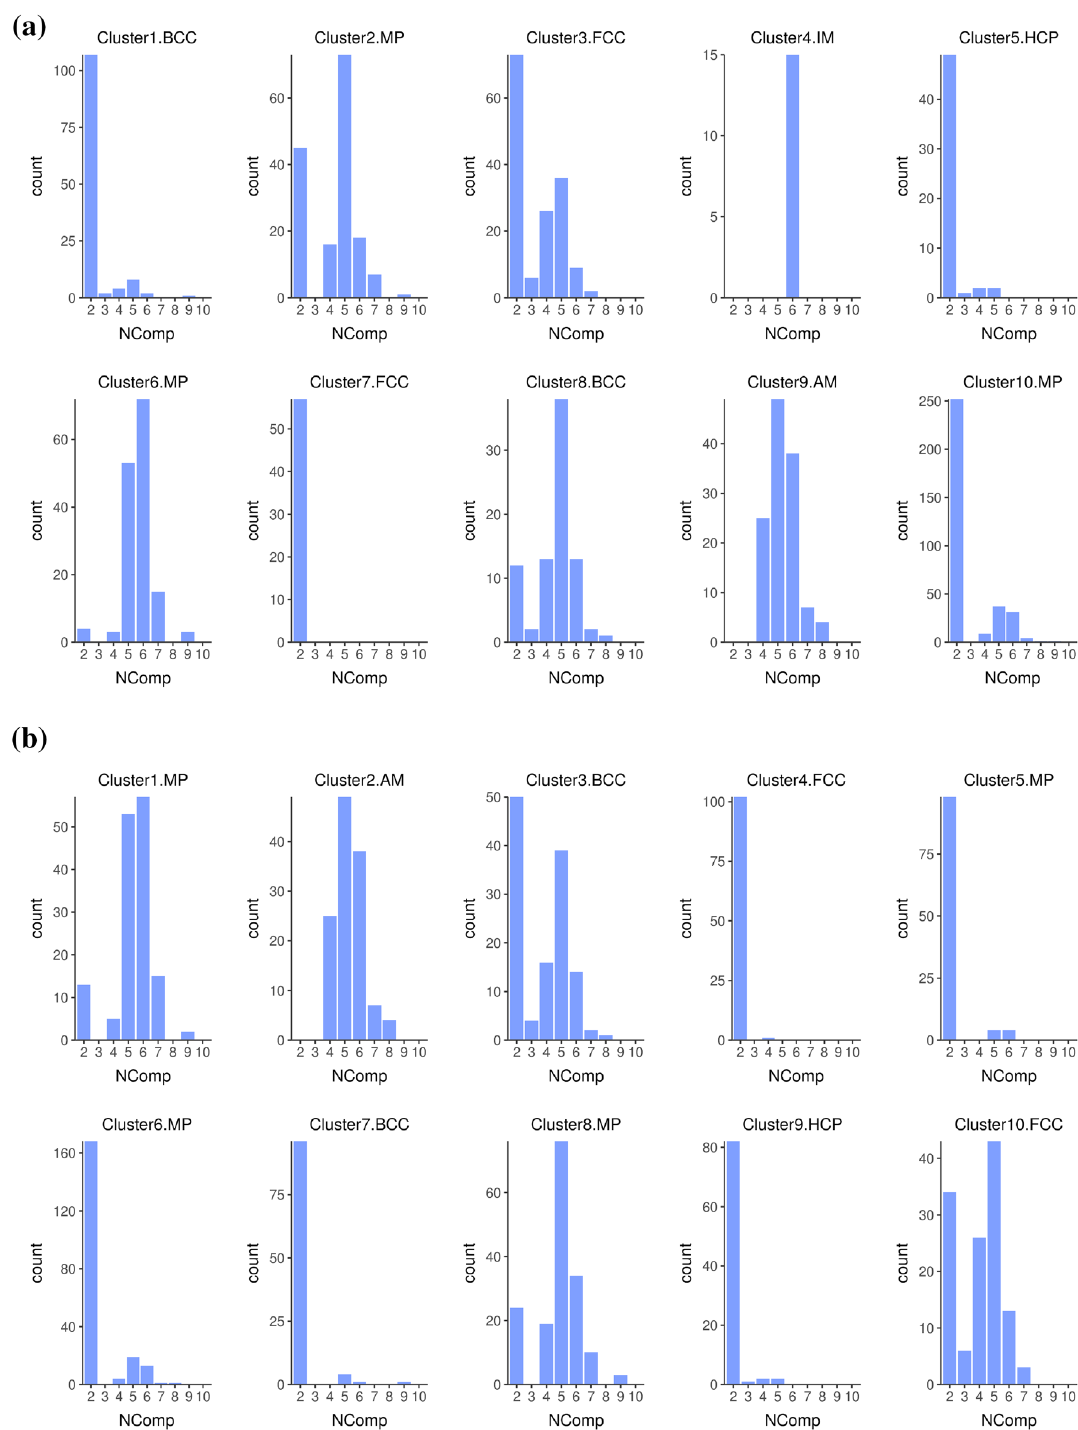
Figure 3. The distribution of the number of components (represented as NComp) for each cluster generated by ( a ) the BD-based and ( b ) SHAP-based data using the k -means clustering algorithm,